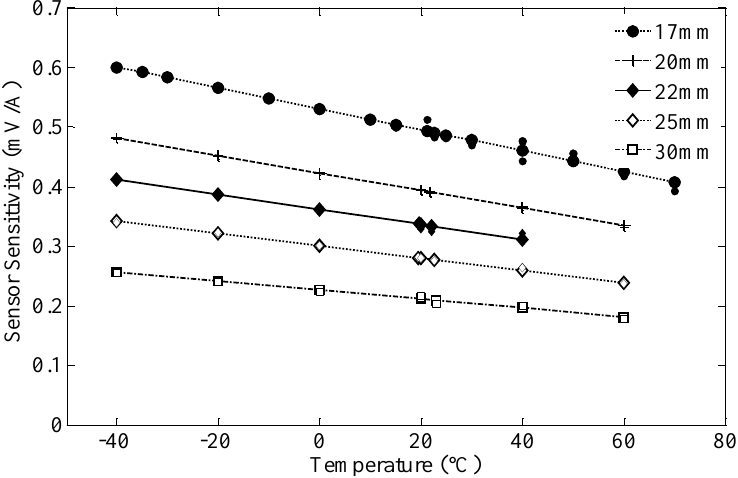
Figure 15. Experimental sensor sensitivity for various temperatures and sensor-wire